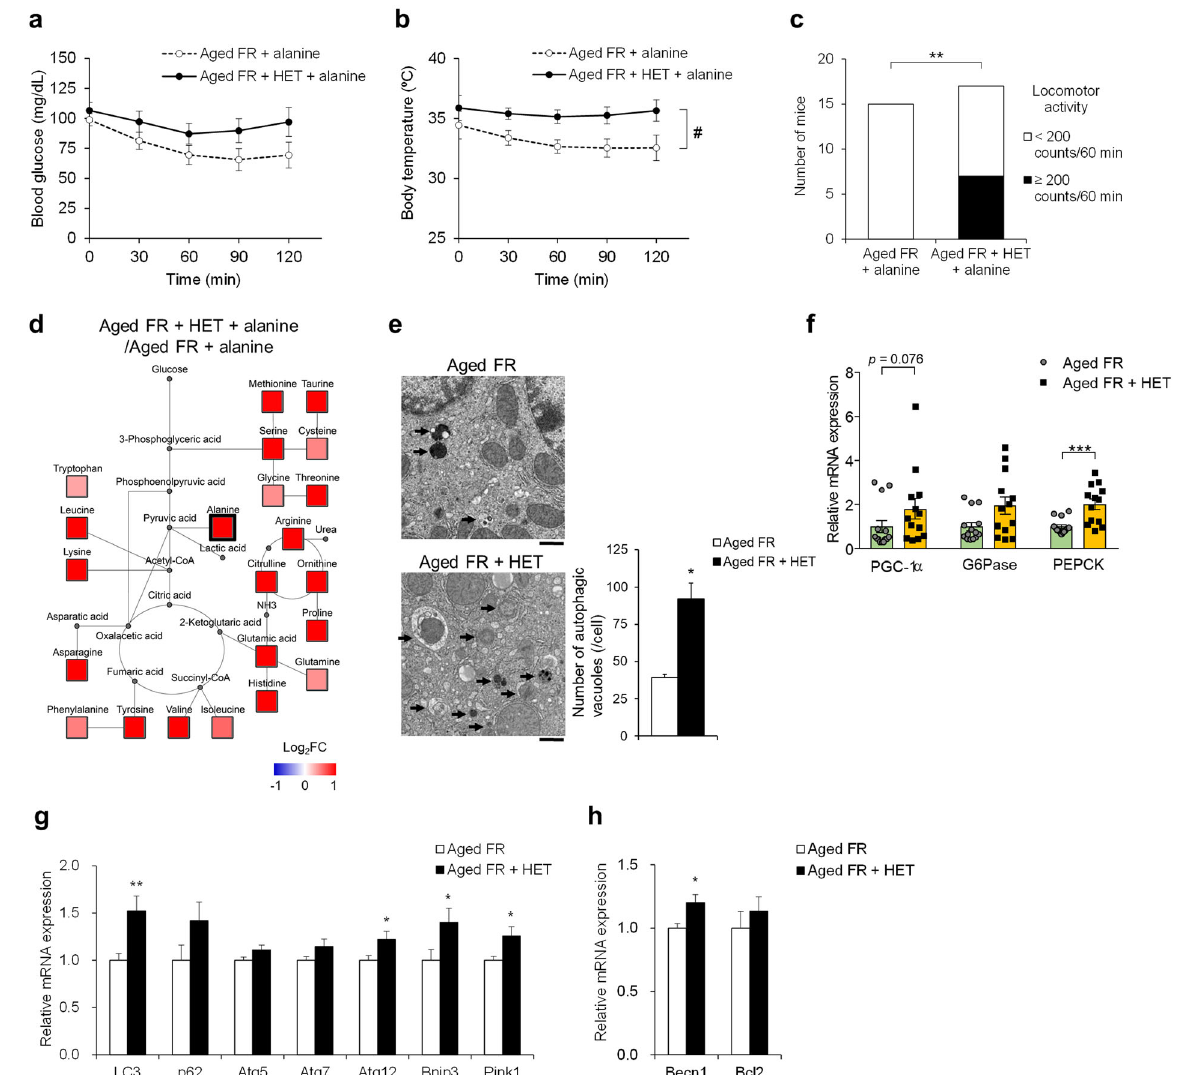
Fig. 8 Effect of hochuekkito on metabolic function on 5-day food restriction. Changes in a blood glucose and b body temperature after alanine injection in aged food-restricted (FR) mice receiving hochuekkito (HET)-containing diet ( n = 11) or control diet ( n = 14). With respect to body temperature, two-way repeated-measures ANOVA revealed signi fi cant effects of HET (#; F (1, 23) = 5, P = 0.0354) and time ( F (4, 92) = 2.86, P = 0.0275). c Mice were divided by levels of locomotor activity at 60 min to 120 min after alanine injection, ** P < 0.01 by chi-square test; control ( n = 15), HET ( n = 17). d Amino acid metabolic pathway map determined from levels detected at 180 min after alanine injection. Mean ratio of plasma amino acid levels in aged FR mice who received HET-containing diet to control diet was shown according to the color scale. Red color represents upregulation and blue color represents downregulation compared to the mean value of mice receiving control diet. e Electron microscopic images of hepatic autophagic vacuoles and the number per cell ( fi ve hepatocytes/mice, n = 4 mice/group). Bar = 3 μ m. Arrows indicate autophagic vacuoles, *** P < 0.001 vs. aged FR by Aspin – Welch t test. f Relative mRNA expression levels of gluconeogenic- related proteins in the liver, *** P < 0.001 by Mann – Whitney test; control ( n = 14), HET ( n = 13). g , h Relative mRNA expression levels of autophagy-related peptides in the liver, * P < 0.05, ** P < 0.01 vs. aged FR by Student ’ s or Aspin – Welch t test; control ( n = 14), HET ( n = 13). Data are presented as mean ± SEM ( a , b , e , f , g , and h